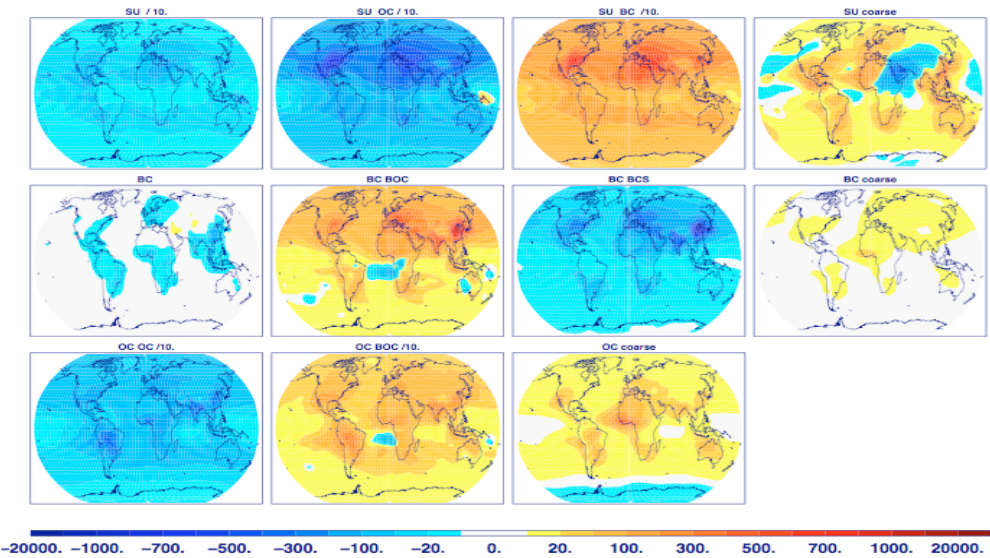
Fig. 1. Differences in present day total column aerosol mass concentrations [µg/m 2 ] per mixing state between experiment S1 and BASE (S1–BASE). The first row shows externally mixed sulfate (population ACC and AKK), sulfate predominantly mixed with OC (OCC, BOC), BC (BC1, BC2, BC3, BCS), and sulfate mixed with coarse aerosols (DS1, DS2, SSC, MXX). Rows two and three show the corresponding changes in mixing state for BC and OC mixtures. Graphs show only the sulfate, or BC, OC respectively, mass present in those mixtures. Some aerosol concentrations are divided by a factor of ten to match the color bar as indicated in the individual title of the map.